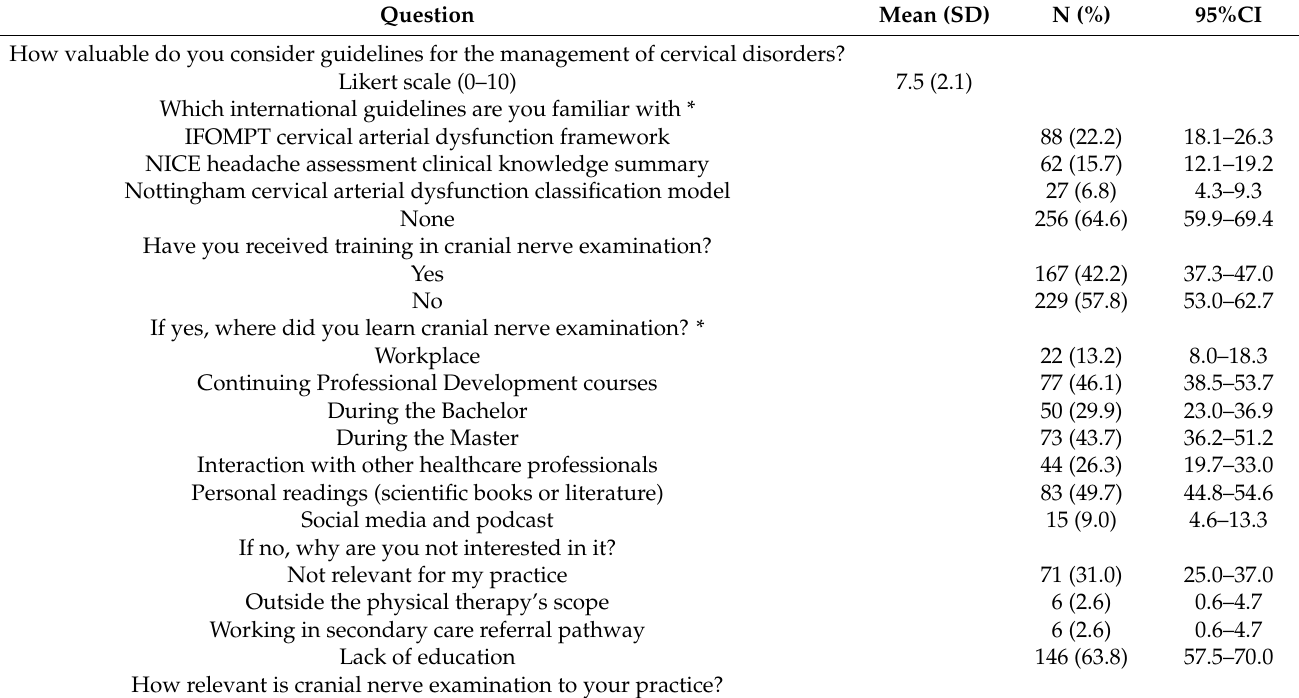
Table 3. Knowledge, education, and confidence with regard to cranial nerve